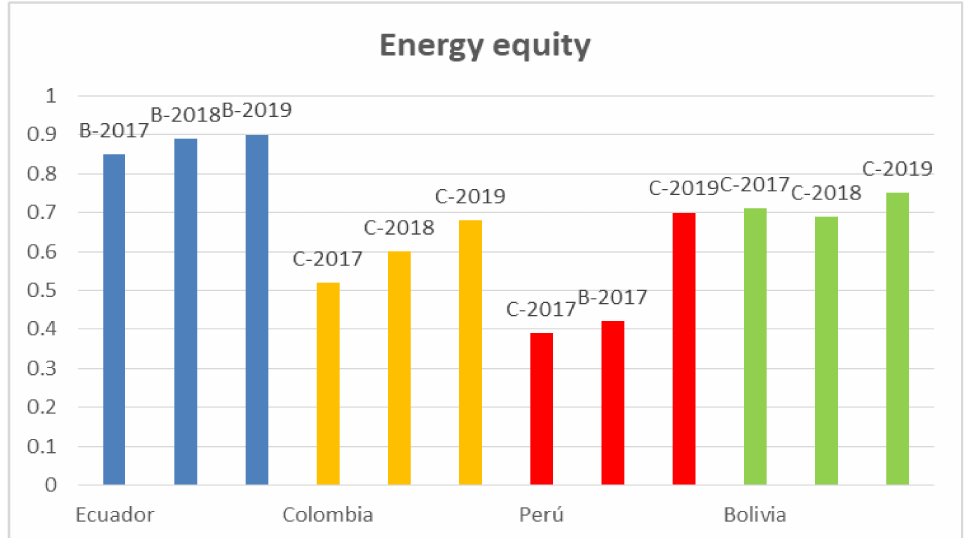
Figure A2. Energy equity dimension by countries in period from 2017 to 2019. A,B,C,D—letter indices according to the WEC methodology: The letter A indicates the highest grade, the letter D—the lowest for each of the